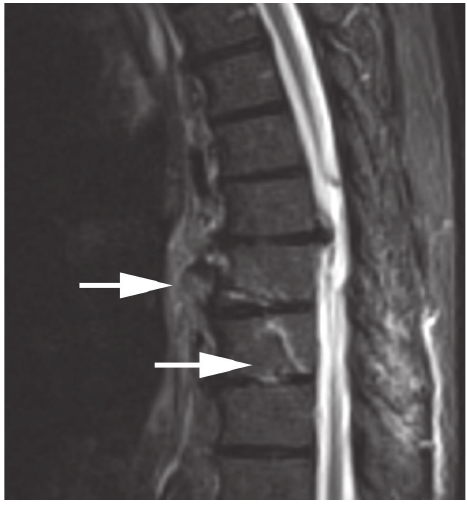
Figure 3: Sagittal MRI, T2 short tau inversion recovery (STIR) sequence, showing unstable acute fractures of the T8-T9 vertebrae ( arrows